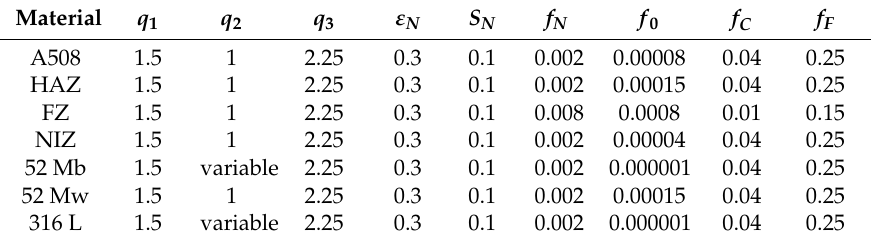
Table 1. The GTN (Gurson-Tvergaard-Needleman) parameters of different material zones [32].